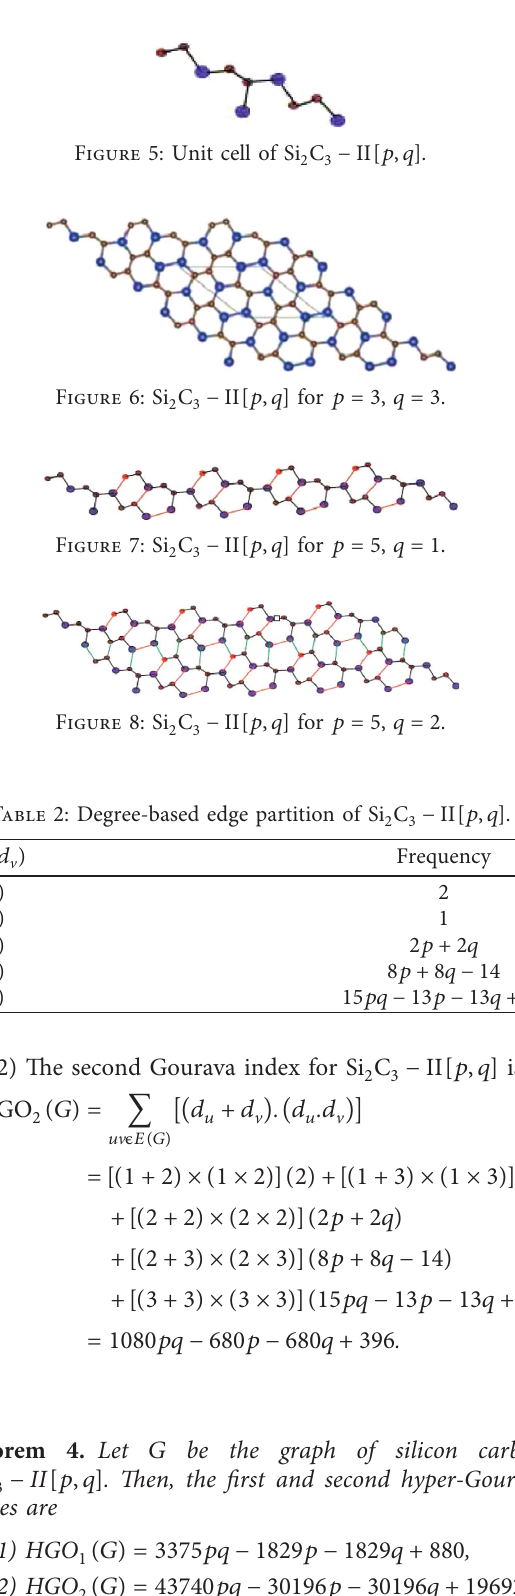
Figure 5: Unit cell of Si